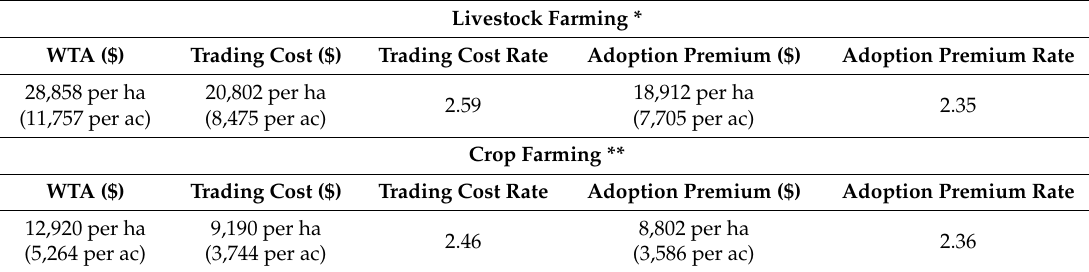
Table 4. Rate and amount of willingness to accept, trading cost, and adoption premium. Livestock Farming